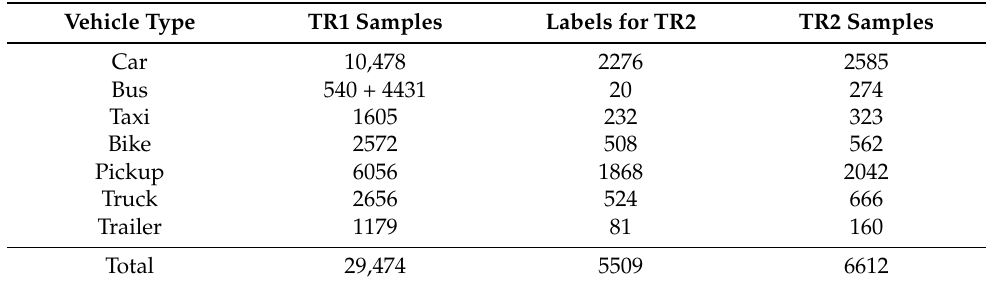
Table 1. Total number of samples in training datasets TR1 and